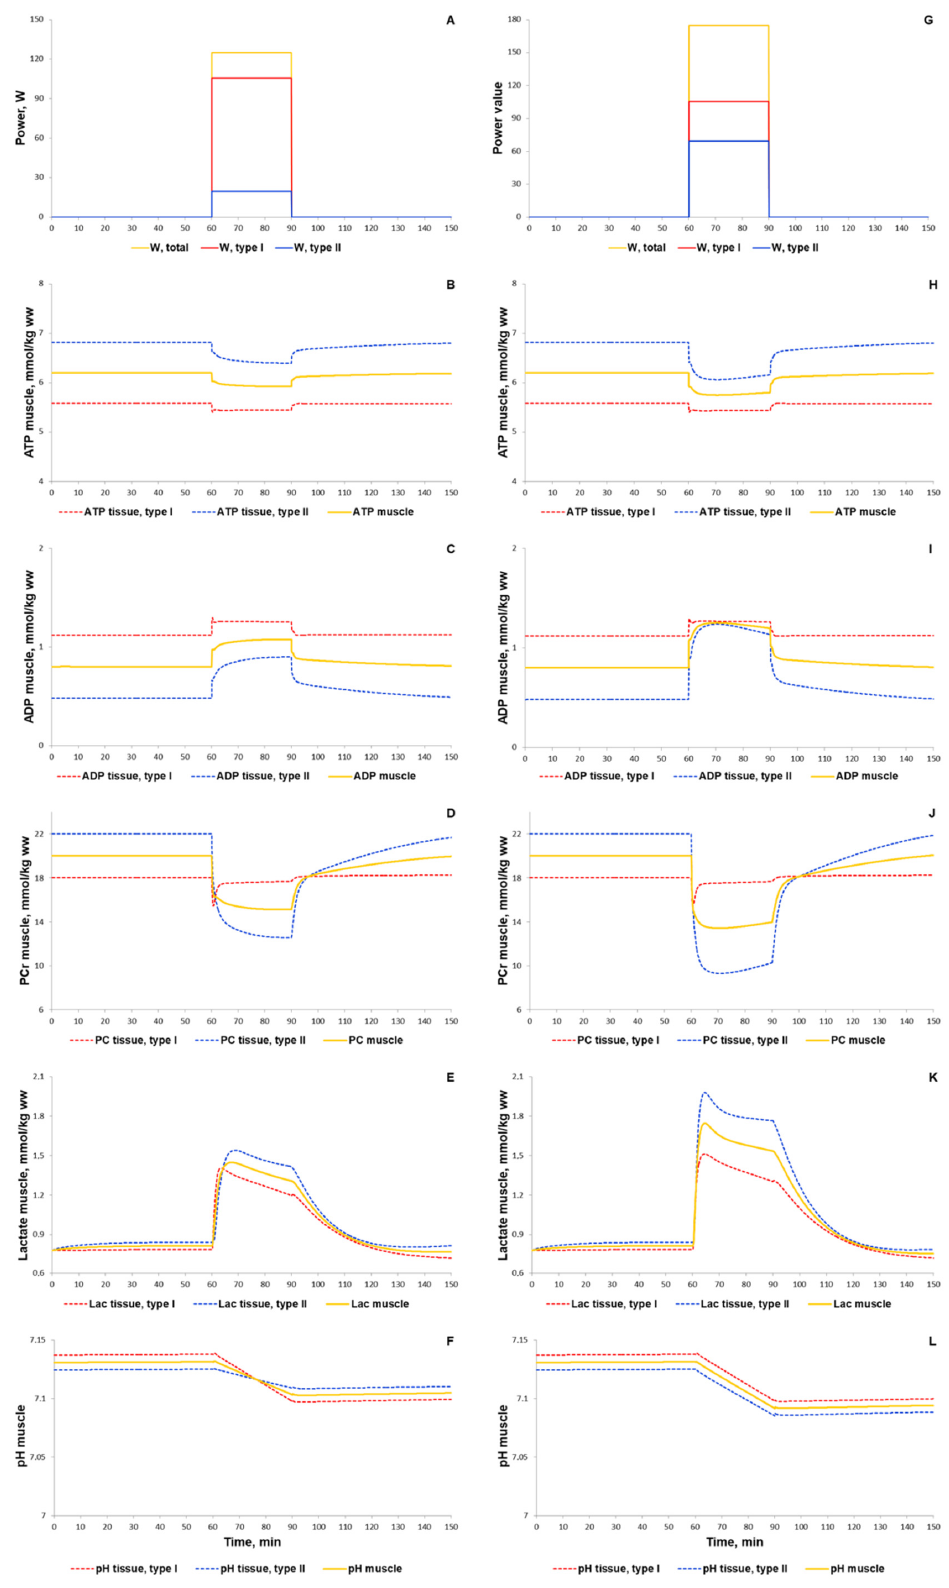
Figure 11. Simulation results for low (50% VO2 max , A – F ) and moderate intensity (70% VO2 max , G – L ) continuous exercises (30 min). ( A , G ) Exercise power and fiber recruitment pattern: total power (orange), power generated by type I (red) and II (blue) fibers; ( B , H ) ATP, ADP, PCr, lactate concentrations, and pH changes in type I (red, dotted) and II (blue, dotted) fibers and in the muscle tissue (orange, solid) during low ( B – F ) and moderate ( H – L ) intensity